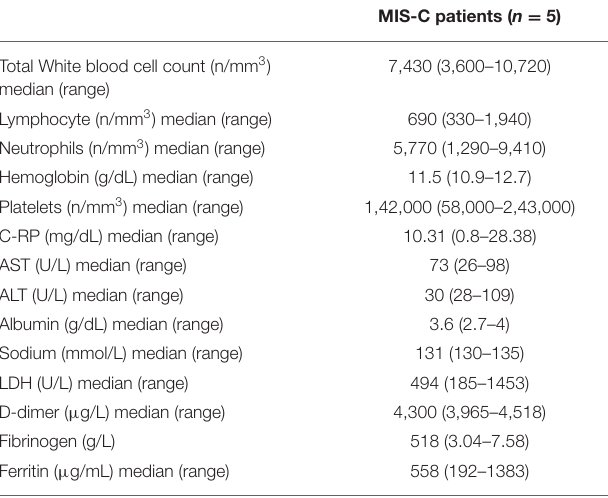
TABLE 2 | Laboratory characteristics of patients with